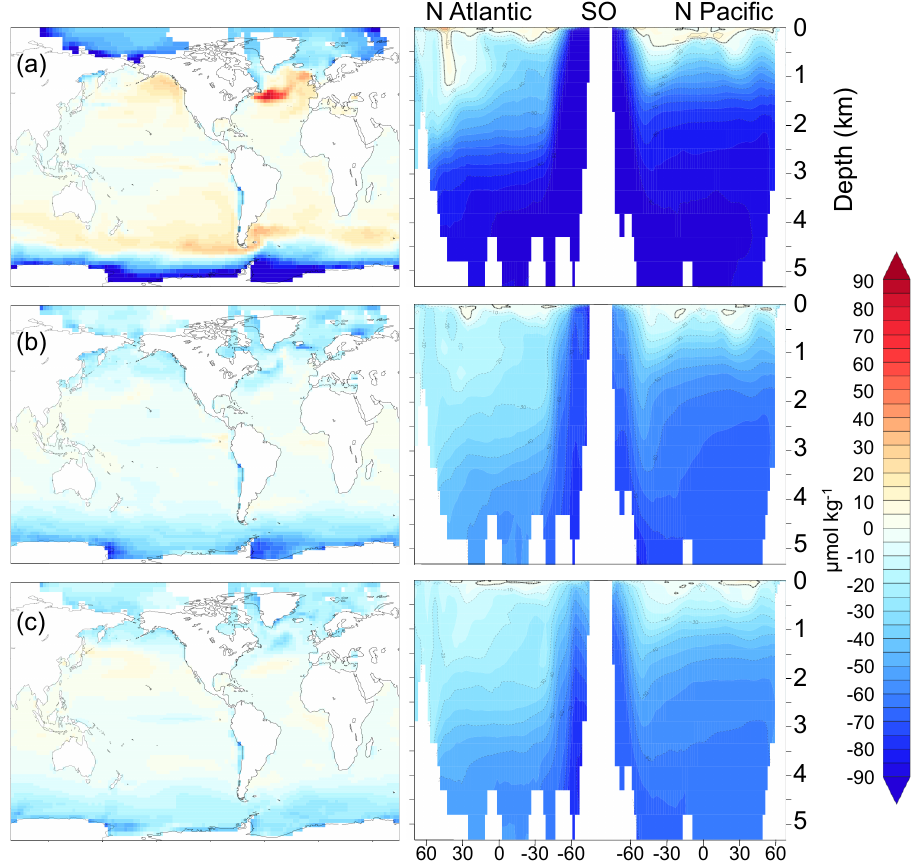
Figure 8. O 2 (µmolkg − 1 ) for simulations (a) cold world; (b) moderate world; (c) hot world (see Sect. 2.2). Depth transects represent the dis North Atlantic (left), Southern Ocean (center), and North Pacific (right).